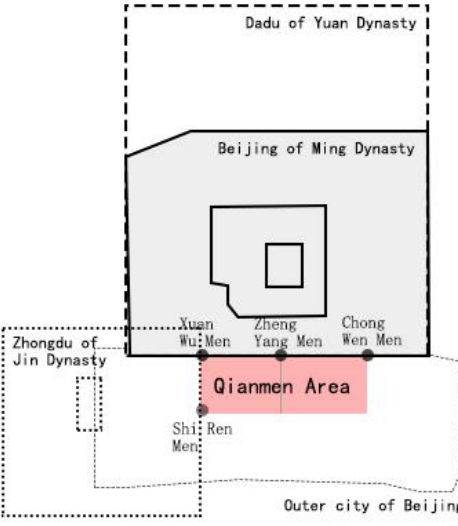
Figure 1. Location of Qianmen area in Ming